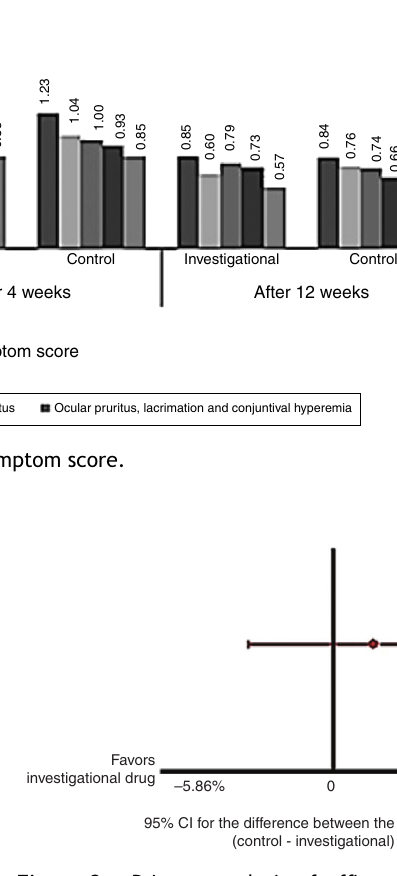
12.65%0–5.86%Favors investigational drug 95% CI for the difference between the succes rates (control - investigational) Figure 3 Primary analysis of efficacy in the PP population ( n = 346).